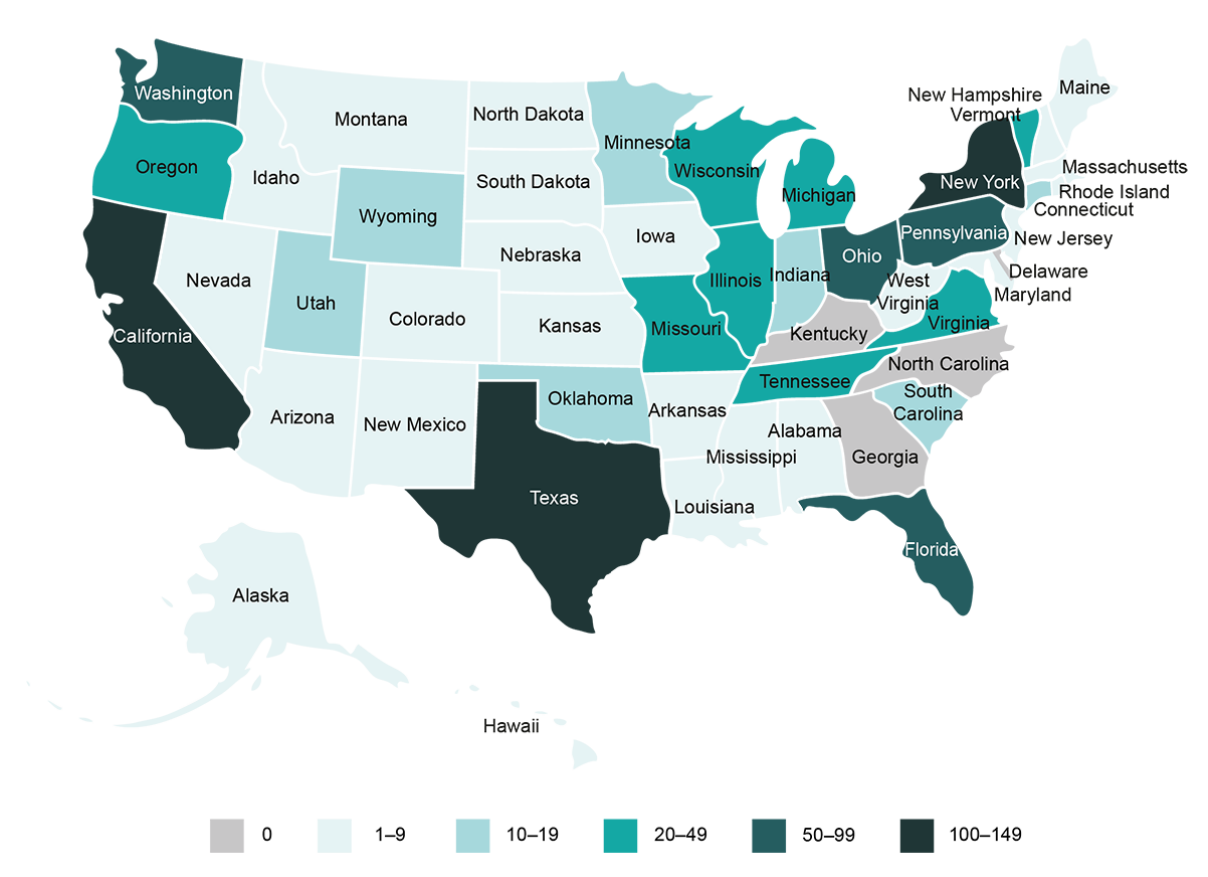
Figure 3. Geographic distribution of participants within the United